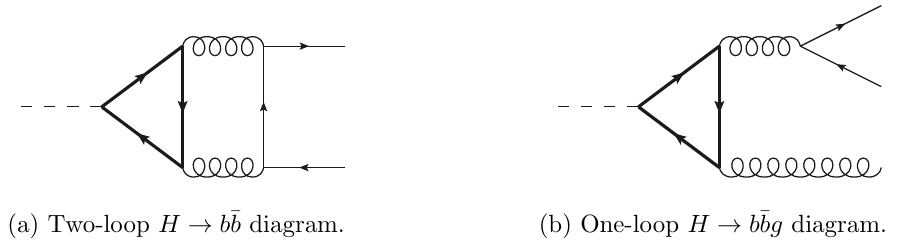
Figure 1. The top-Yukawa contributions to the H ! b (cid:22) b and H ! b (cid:22) bg amplitudes. The solid thick lines represent a top quark while the thin solid lines denote the external b